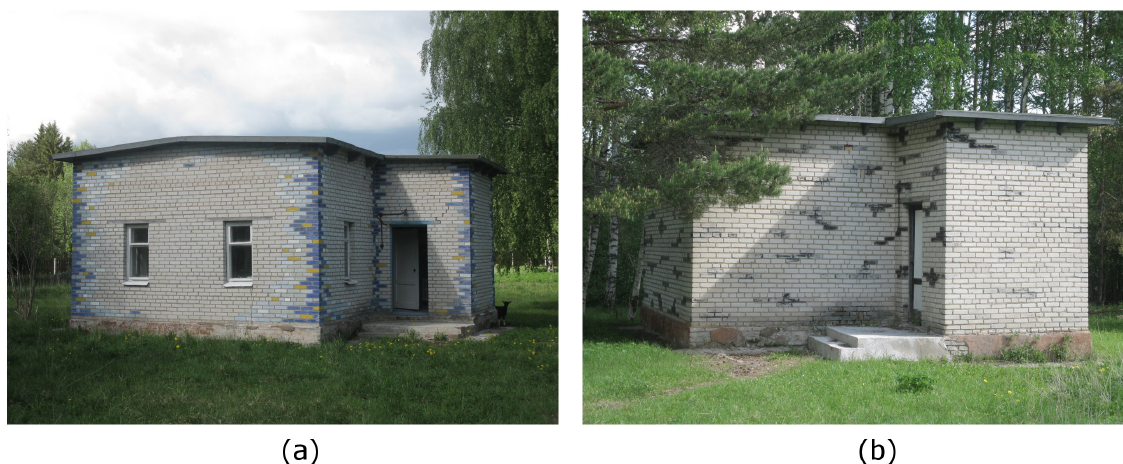
Figure 3. Absolute (a) and variation (b) pavilions of the Saint Petersburg